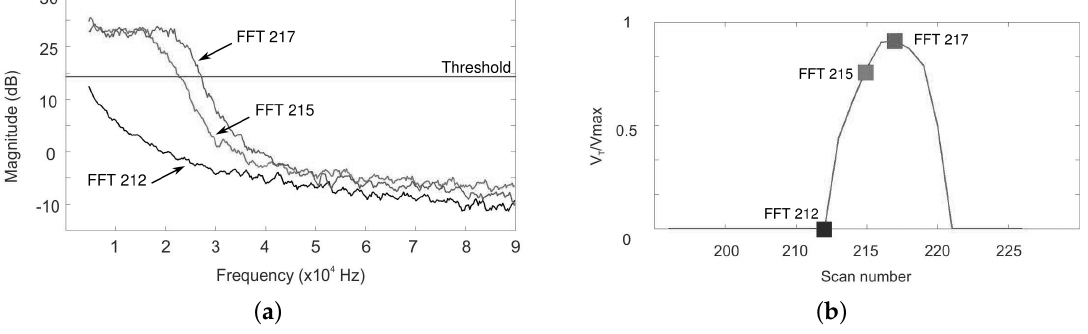
Figure 25. One line scan on rat aorta by OFI: ( a ) three FFT spectra: outside the aorta (FFT212), 300 µm (FFT215) and 500 µm (FFT217) inside the aorta; ( b ) Fluid velocity profile reconstructed by 25 scan